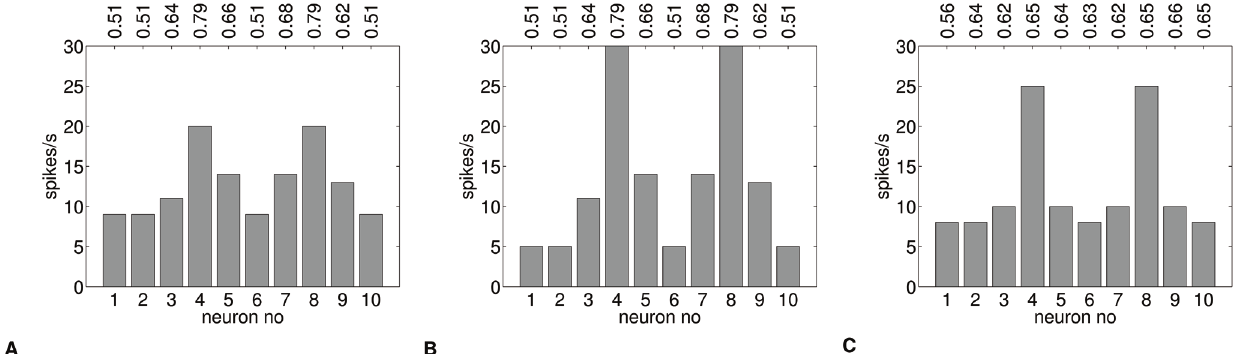
Figure 6. Positive pattern learning. Spike frequency histograms for 10 adaptive neurons ( θ =11.5Hz) ( A ) response of naive neurons to P learn ( B ) re sponse of P learn -adapted neurons to P learn ( C ) P learn -adapted neurons tested with P noise . Average synaptic input (nA/cm 2 ) for each neuron is shown on top. Responses in ( A ) and ( B ) to the same input P learn are different, a pat tern similar to P learn emerges in response to uniform (noise) pattern input in ( C